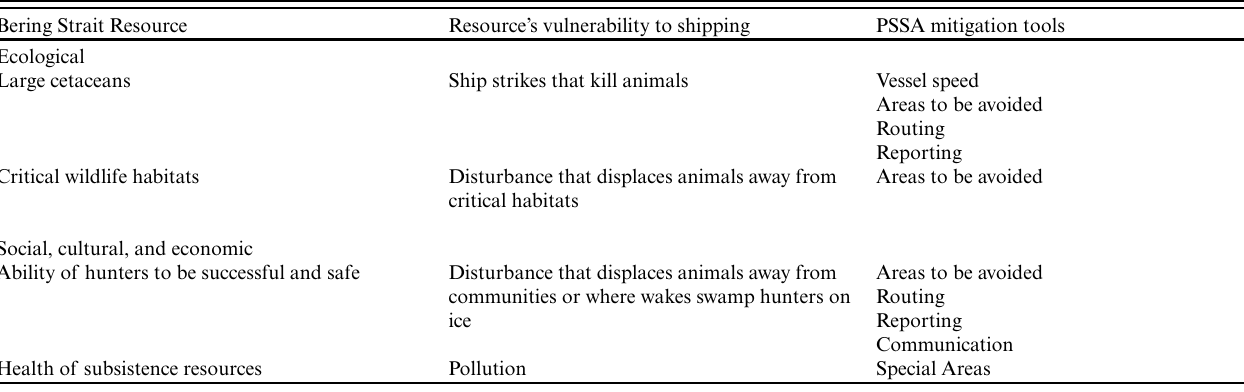
Table 3 . Selected examples of Bering Strait resources, vulnerabilities, and mitigation